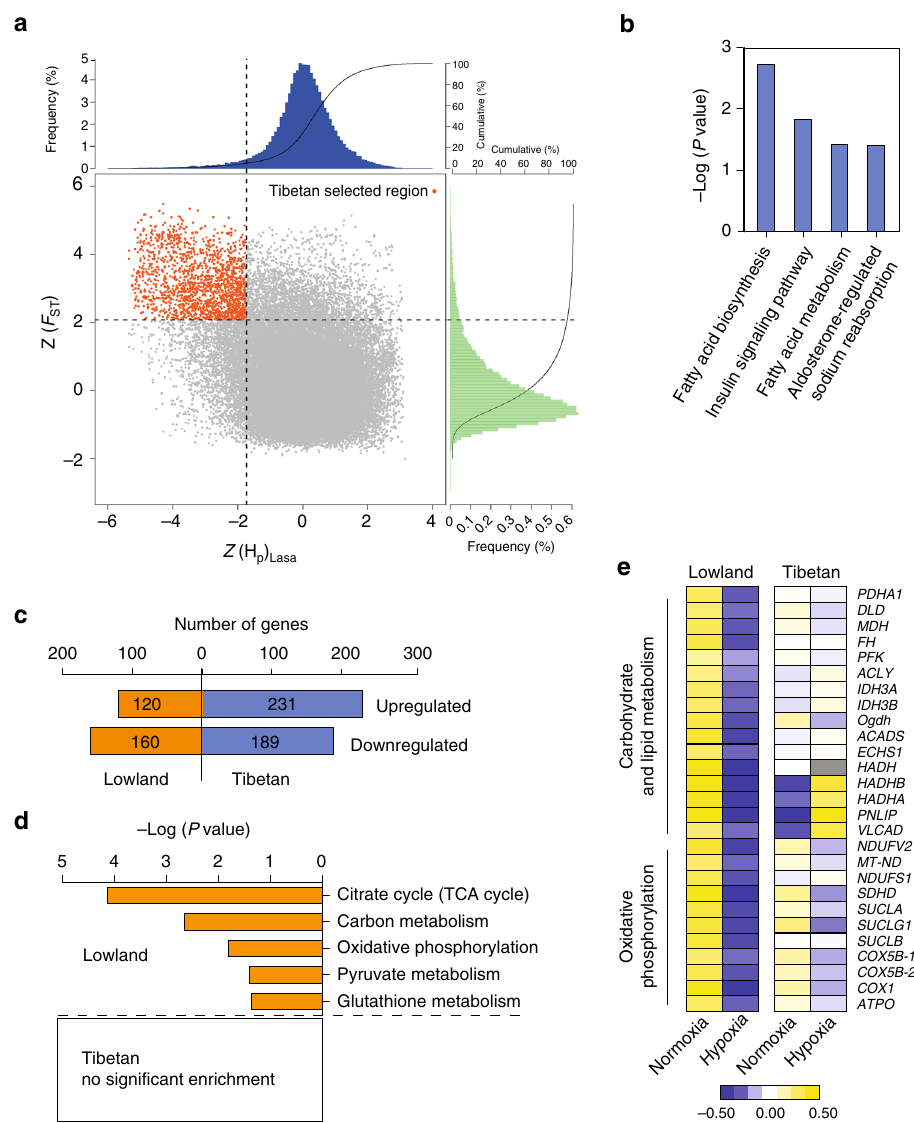
Fig. 2 Selective sweep and expression analysis of hypoxia adaptation. a Distribution of Z -transformed fi xation (Z F ST ) and heterozygosity (Z H P ), calculated in 100-kb sliding windows. Genomic region (red point) located at top left of the dash lines (5% of empirical maximum F ST and minimum H P ) is identi fi ed as high-altitude adaptation-associated region in Tibetan locusts. Genes in this region are positively selected genes (PSGs). b KEGG enrichment of PSGs. c Number of differentially expressed genes (DEGs) in response to hypoxia induction through transcriptome sequencing. d KEGG enrichment of DEGs. Only KEGG terms with P < 0.05 are shown (Fisher ’ s Exact Test). e Expression pattern of DEGs involved in energy metabolism. Heat map signal indicates log2 fold-change values relative to the median expression level within the group. Yellow signal represents higher expression and blue represents lower expression relative to the median level within the